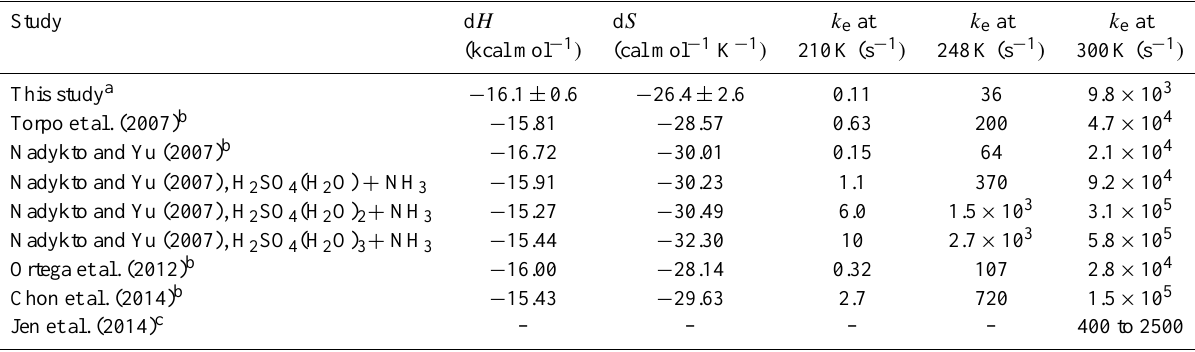
(cid:113) NH 3 cluster from this study and from the literature.